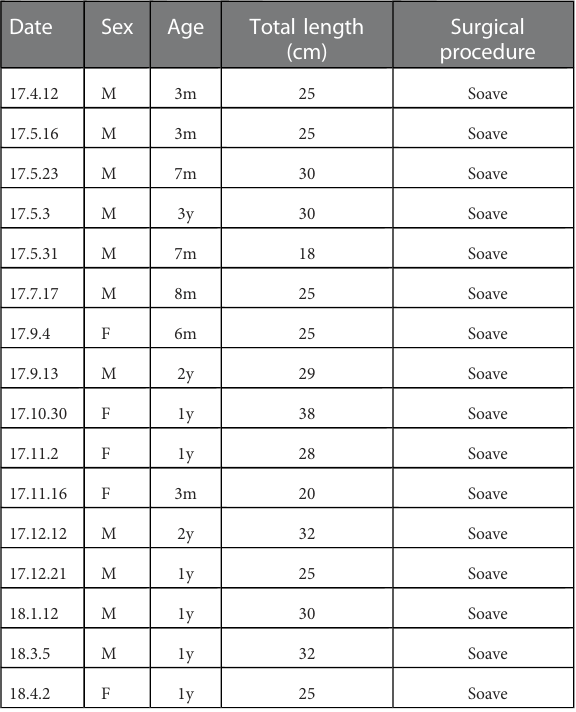
TABLE 1 Clinical data of pediatric patients with